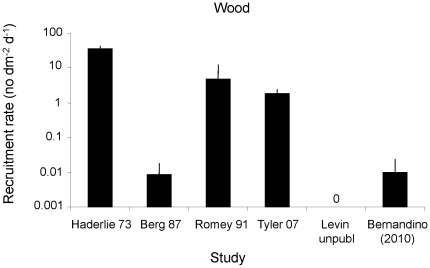
Rate of recruitment of bivalves (+SD) on wood in different studies.
[43]: Xylophaga washingtonia; [44], [45]: X. atlantica; [46]: X. depalmai; [15]: Bivalve unid. Q and Thysaridae sp. 1.